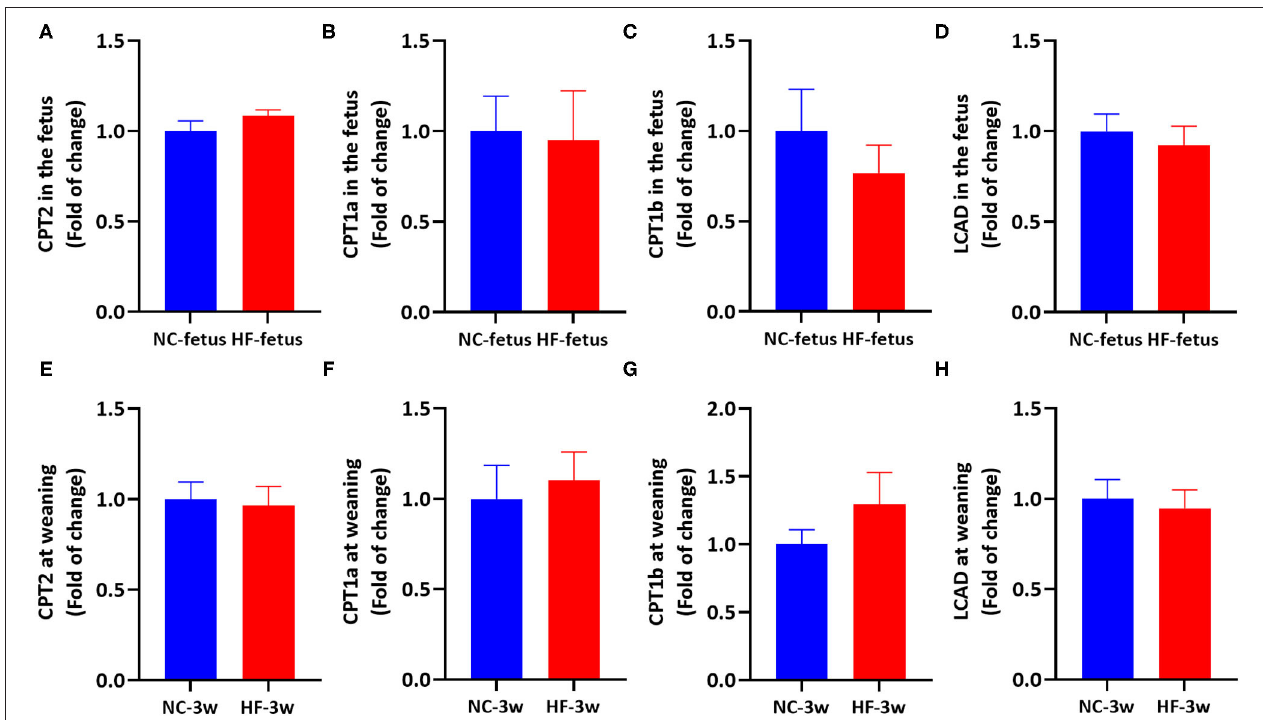
FIGURE 7 | Maternal HF feeding did not affect FAO-related gene mRNA expression in offspring at fetal and weaning age. (A–D) hepatic mRNA expression in the fetus. (A) CPT2; (B) CPT1a; (C) CPT1b; (D) LCAD; (E–H) hepatic mRNA expression in the offspring at weaning. (E) CPT2, (F) CPT1a, (G) CPT1b, (H) LCAD. Data represented as the mean ± SEM. (NC-fetus, n = 6; HF-fetus, n = 7; NC-3w, n = 8; HF-3w, n = 8). NC, normal chow diet; HF, high-fat diet; 3w, the third week. CPT2, carnitine palmitoyltransferase 2; CPT1a, carnitine palmitoyltransferase 1a; CPT1b, carnitine palmitoyltransferase 1b; LCAD, long chain acyl-CoA